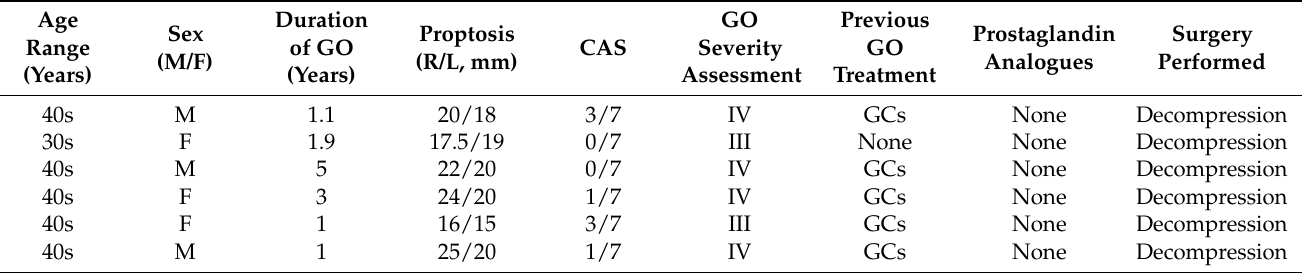
Table 1. The clinical characteristics of donors in this